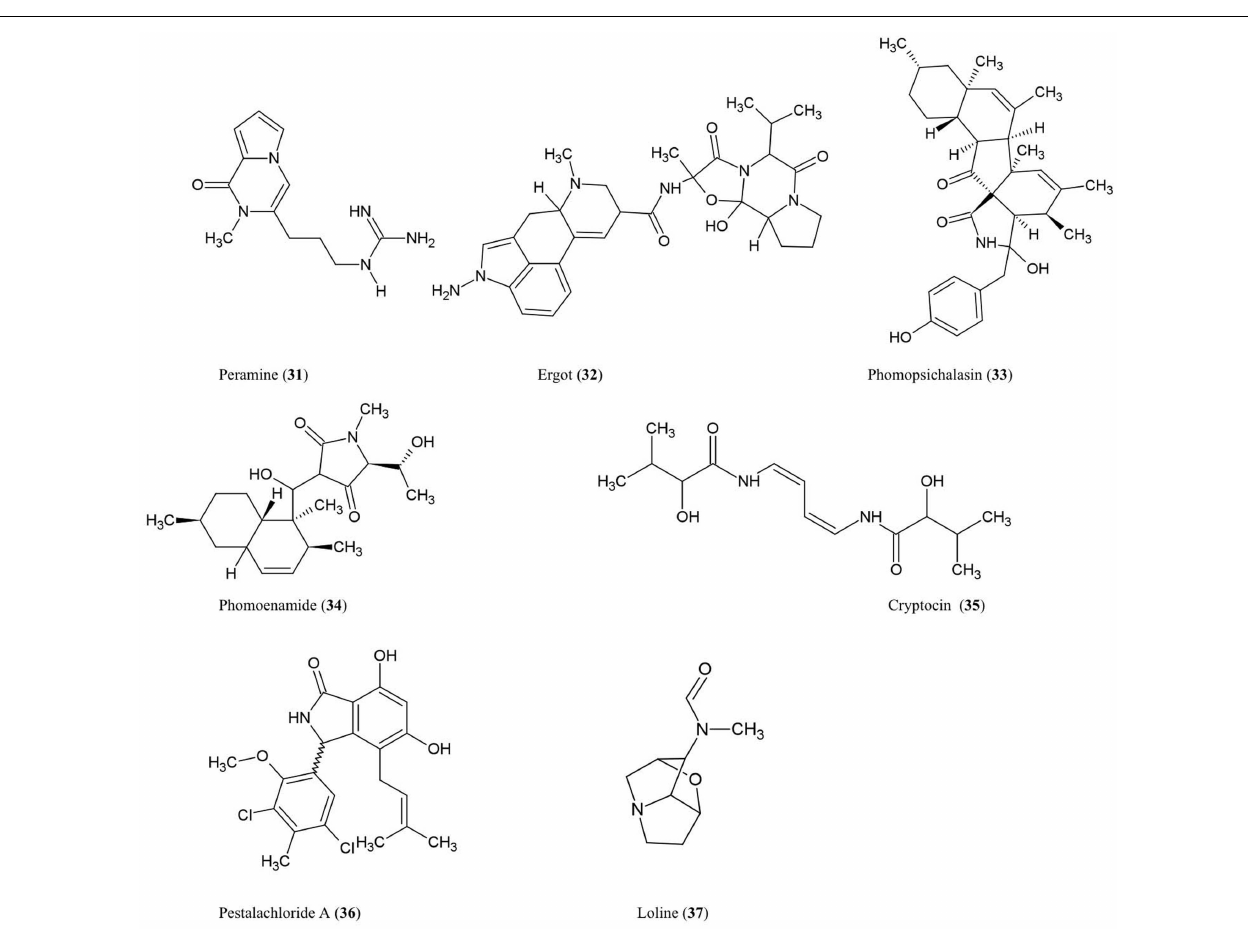
FIGURE 4 | Structures of alkaloid derivatives of fungal endophyte origin